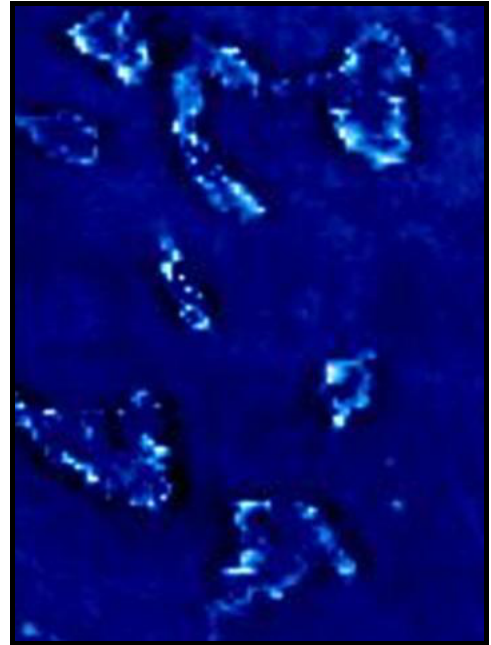
Figure 6. An enlargement of the derived height-to-width ratio for the upper left corner of the study area as shown in Figure 5.